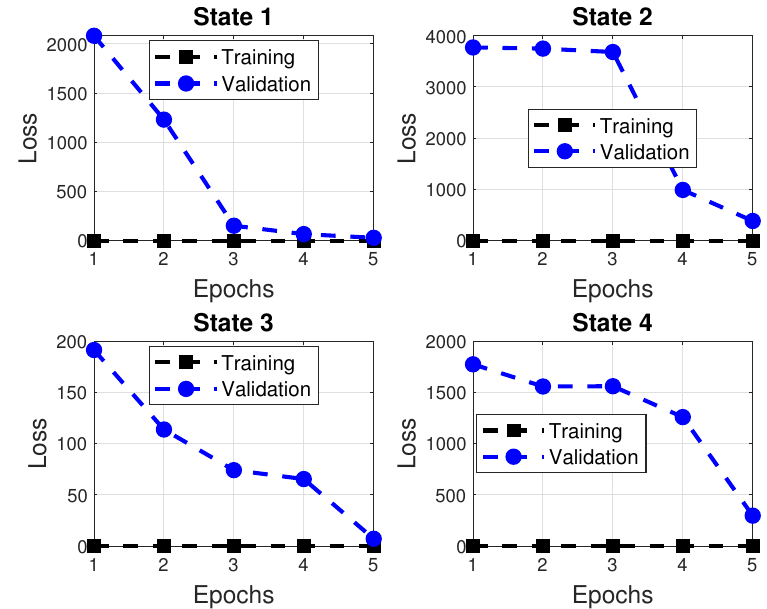
Figure 4. Training and validation MSE losses for Decision Tree.